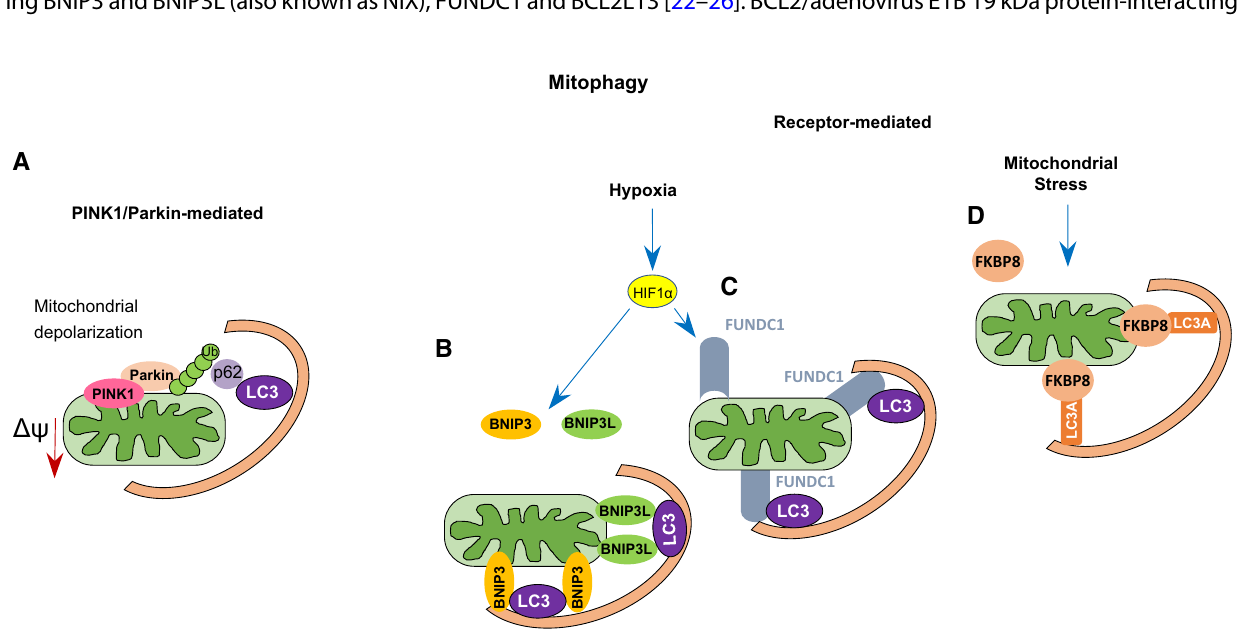
Fig. 1 Schematic representation of PINK1/Parkin- and receptor-mediated mitophagy (see the text for the details). A PINK1/Parkin-mediated mitophagy, B – D BNIP3- FUNDC1- FKBP8-mediated mitophagy,